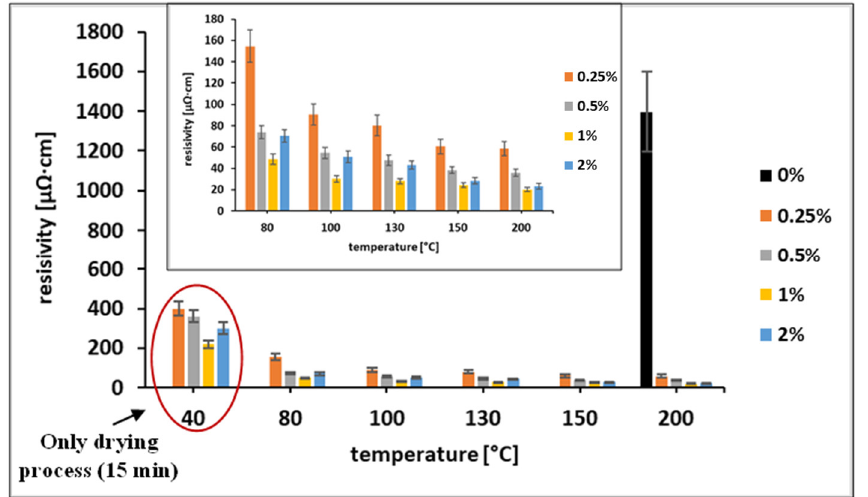
Figure 5. Dependence of the resistivity of the coatings based on Ni@Ag NPs on the concentration of OA (0–2%) after drying (40 °C, 15 min) and sintering (80–200 °C, heating duration 30 min). The inset graph presents the data in the resistivity range of 0–180 µΩ·cm.